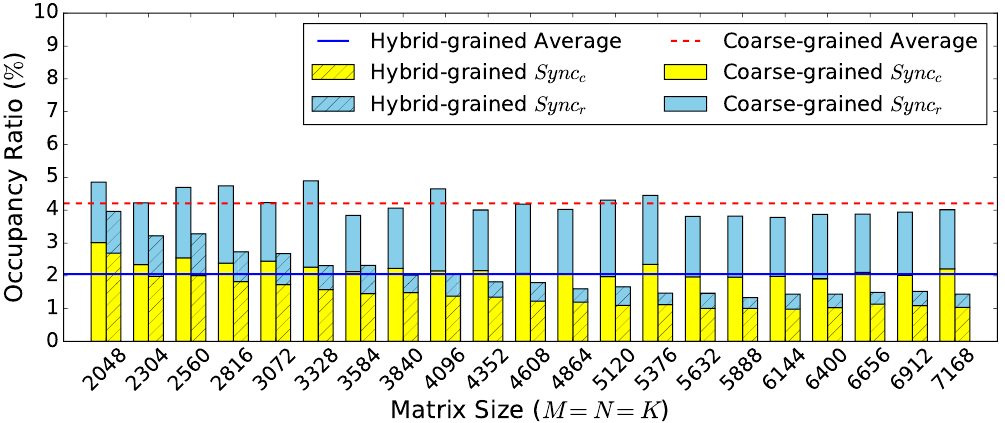
Figure 6. Synchronization overhead. The hybrid-grained configuration is ( 2,2,0.1 )